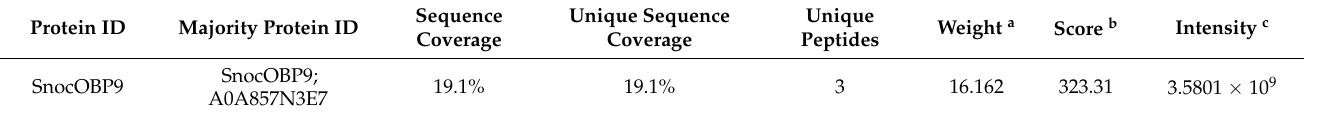
Figure 2. ( A ) Western blot analysis of SnocOBP9 with 6*His-Tag. Lane M represents molecular marker. ( B ) SDS-PAGE analyses of the expression and purification of recombinant SnocOBP9. Lane SnocOBP9 represents purified recombinant protein; lane M represents molecular marker. Table 1. The LC-MS/MS analysis of SnocOBP9.